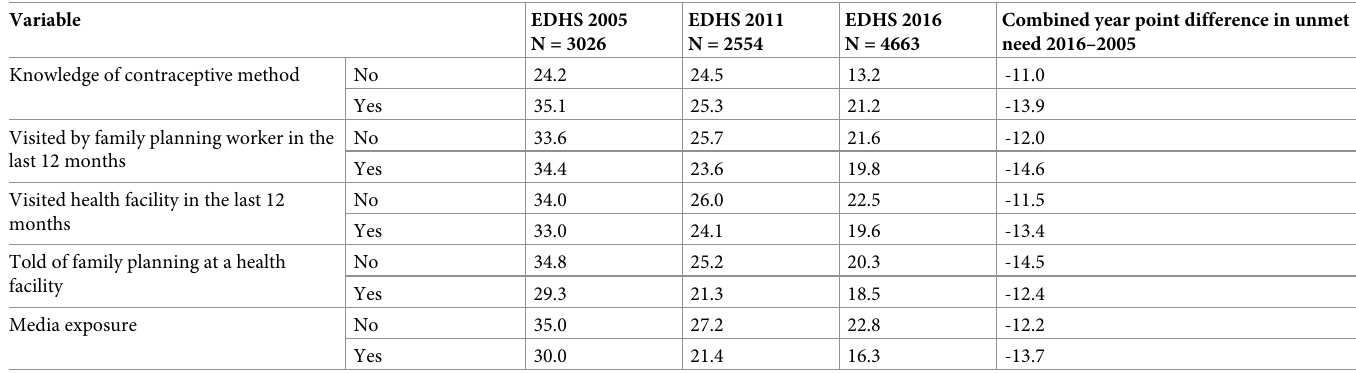
(Table 1) who had three to four living children over time increases the rate of unmet need by 1.52% (Table 4) among currently married reproductive age group women. The unmet need rate increased by 3.46% (Table 4) as the proportion of women in rural areas declined from 89.4% to 83.8% (Table 1). Although the change was small (1.26%) (Table 4), a drop in the pro- portion of Muslim religious followers in the sample from 37.2% to 34.6% (Table 1) revealed a significant decrease in unmet family planning